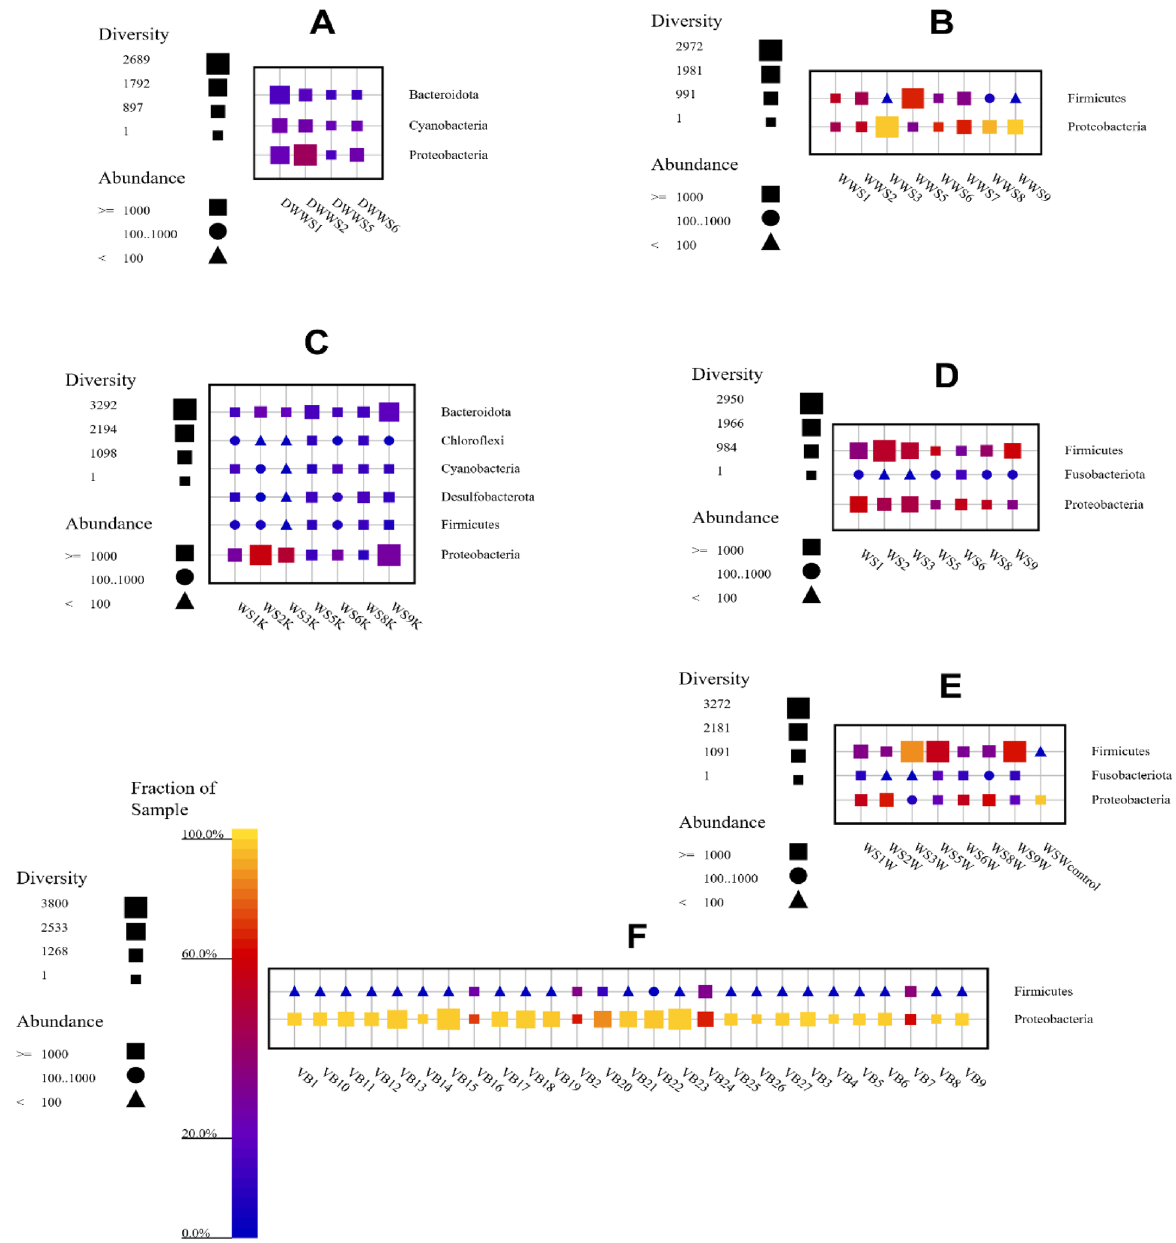
Figure 1. Taxonomic fingerprint of ( A ) directly studied water samples (DWWS1–DWWS6), ( B ) pre-enriched water samples (WWS1–WWS9), ( C ) directly studied sediment samples (WS1K–WS9K), ( D ) pre-enriched sediment samples in buffered peptone water (WS1–WS9), ( E ) pre-enriched sediment samples in buffered peptone water supplemented with lake water (WS1W–WS9W), ( F ) pre-enriched fish samples (VB1–VB27) of Lake Van at phylum-level (The figure was created using SILVA NGS 1.4 Gevaş (pier) could not be amplified. Bacterial communities, especially fastidious bacteria, present in water were enriched by collecting residues on the surface of filter. NGS results showed that direct DNA extracted water samples (n:4) revealed 82,247 reads (47,287 classified sequences, 14,971 clustered sequences, and 32,798 OTUs) and 136,754 reads (85,118 classified sequences, 24,967 clustered sequences, and 23,151 OTUs) were recorded in pre-enriched water samples (n:8). In bacterial community structure of directly studied water samples, Proteo- bacteria, Bacteroidota, and Cyanobacteria were identified at phylum-level (Fig. 1A). In the case of pre-enriched water samples, Proteobacteria and Firmicutes were identified (Fig. 1B). Cyanobiaceae and Rhodobacteraceae were determined at family-level of direct water samples (Fig. 2A). Whereas, pre-enriched water samples were dominated by Vibrionaceae and Aeromonadaceae at family-level taxonomic classification. Among all the other locations, Gevaş location (WWS5) showed the highest Firmicutes population. In fact, pre-enrichment especially